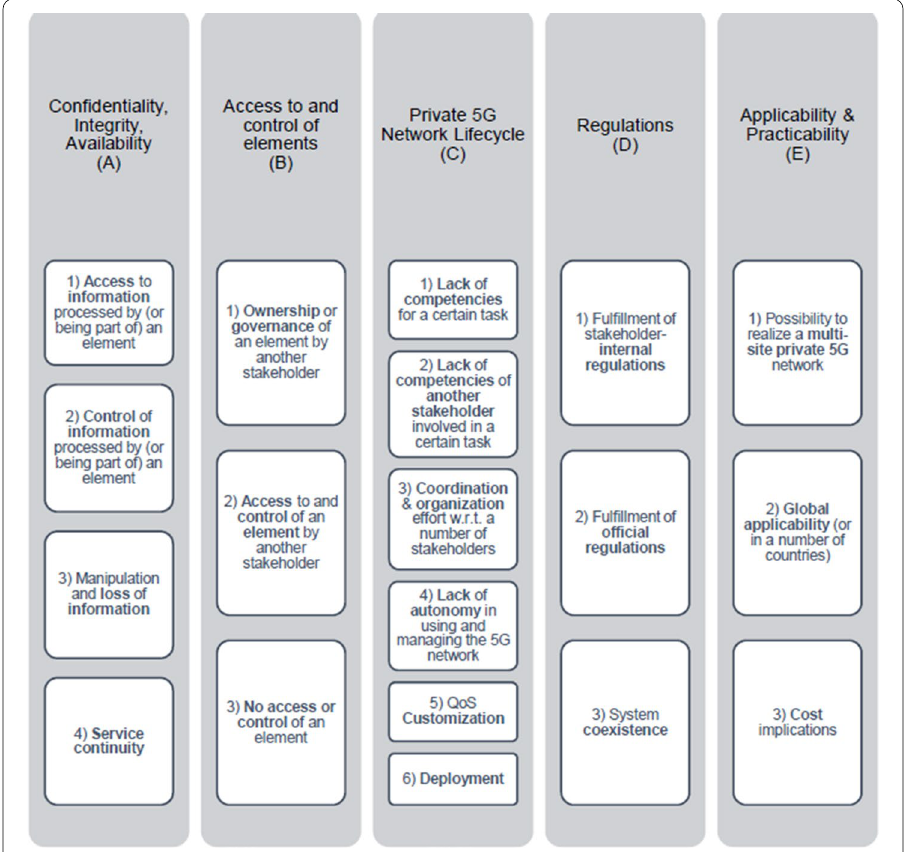
Fig. 7 Categories for concerns regarding operator